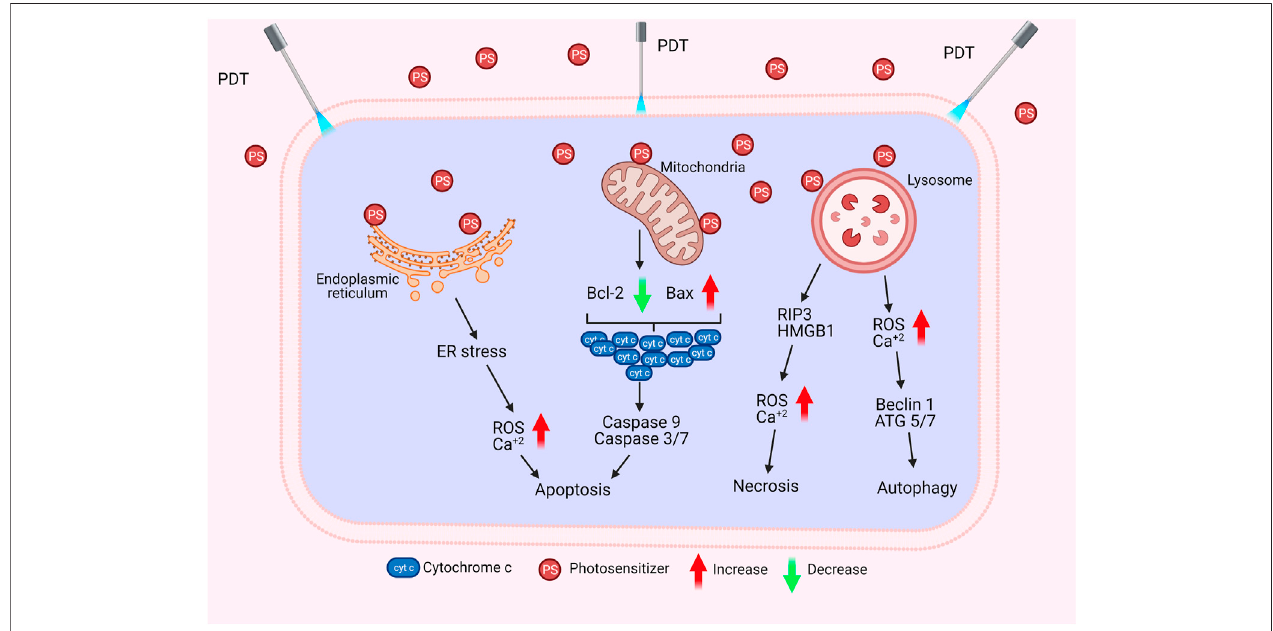
FIGURE 4 | Cell Death by PDT. PDT may induce apoptosis, necrosis, or autophagy via different